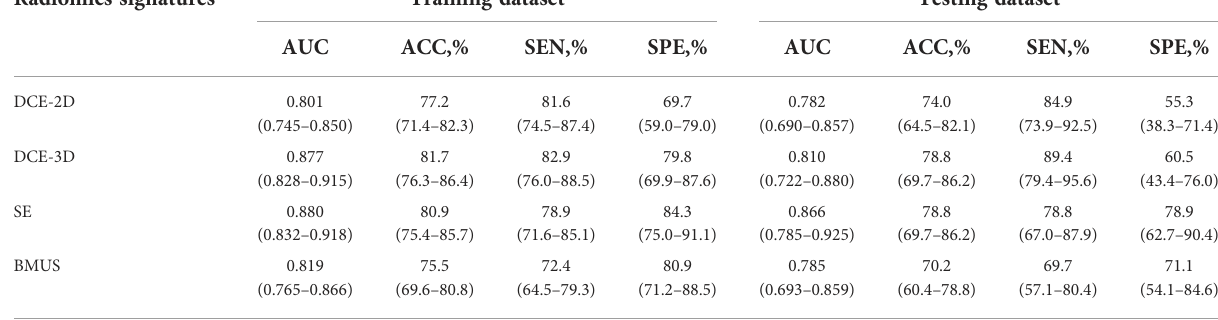
TABLE 2 The diagnostic performance of single modality radiomics